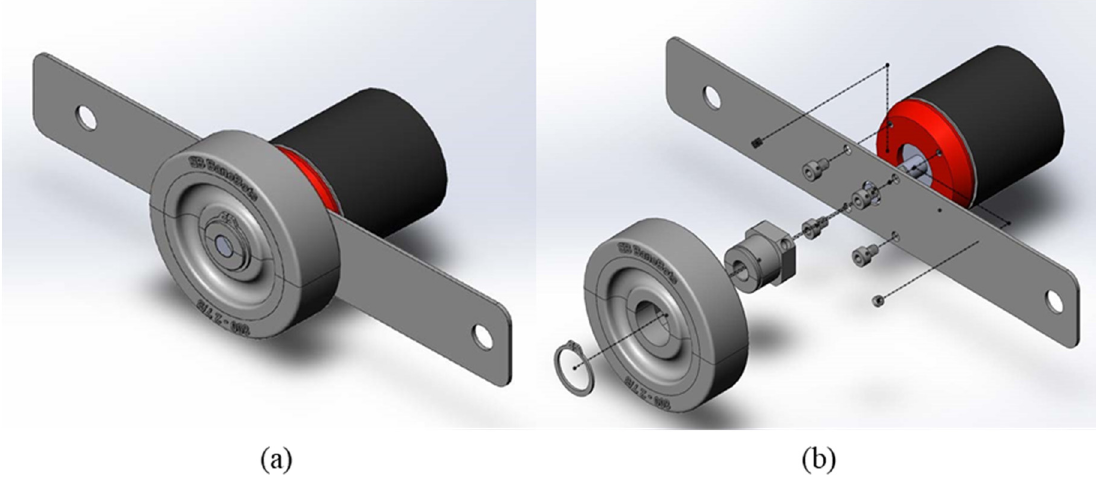
Figure 6. ( a ) The motor assembly as designed; ( b ) the exploded assembly view of the design.